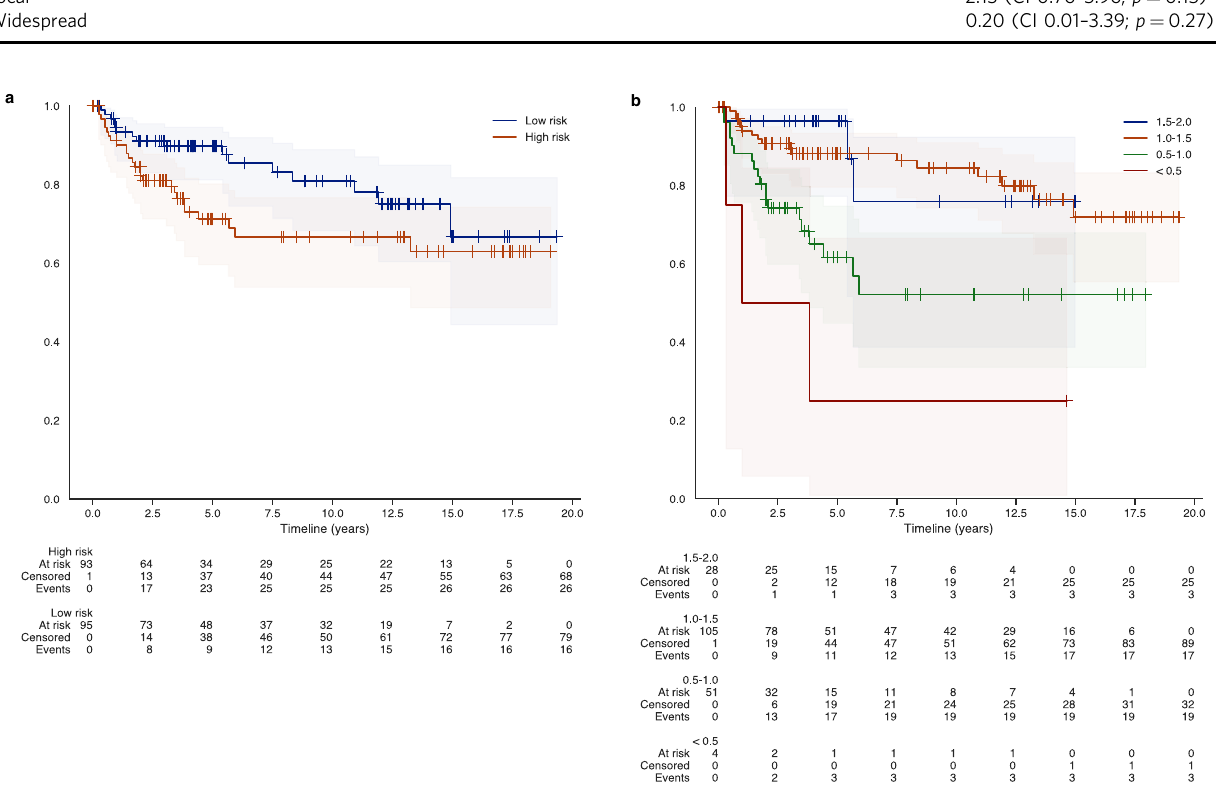
Fig. 2 Kaplan – Meier plot for New York Langone external validation cohort. Groups were separated using the median DLS biomarker score in this cohort ( a ) and using four thresholds ( b